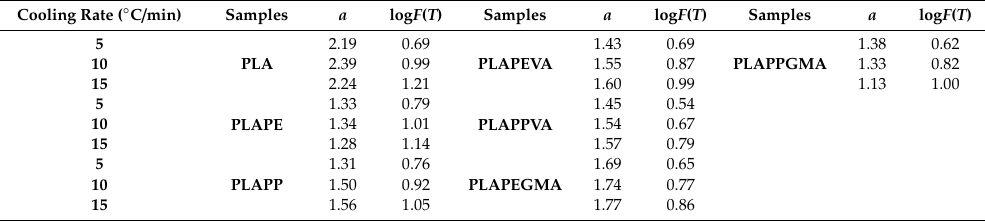
Table 5. Crystallization kinetic parameters at various cooling rates for the PLA / POE blends based on the Mo